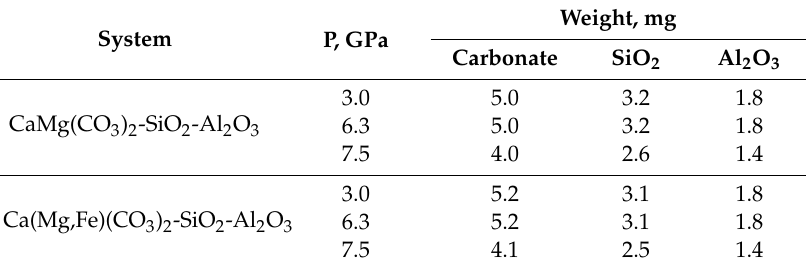
Table 1. Weights of initial reagents.